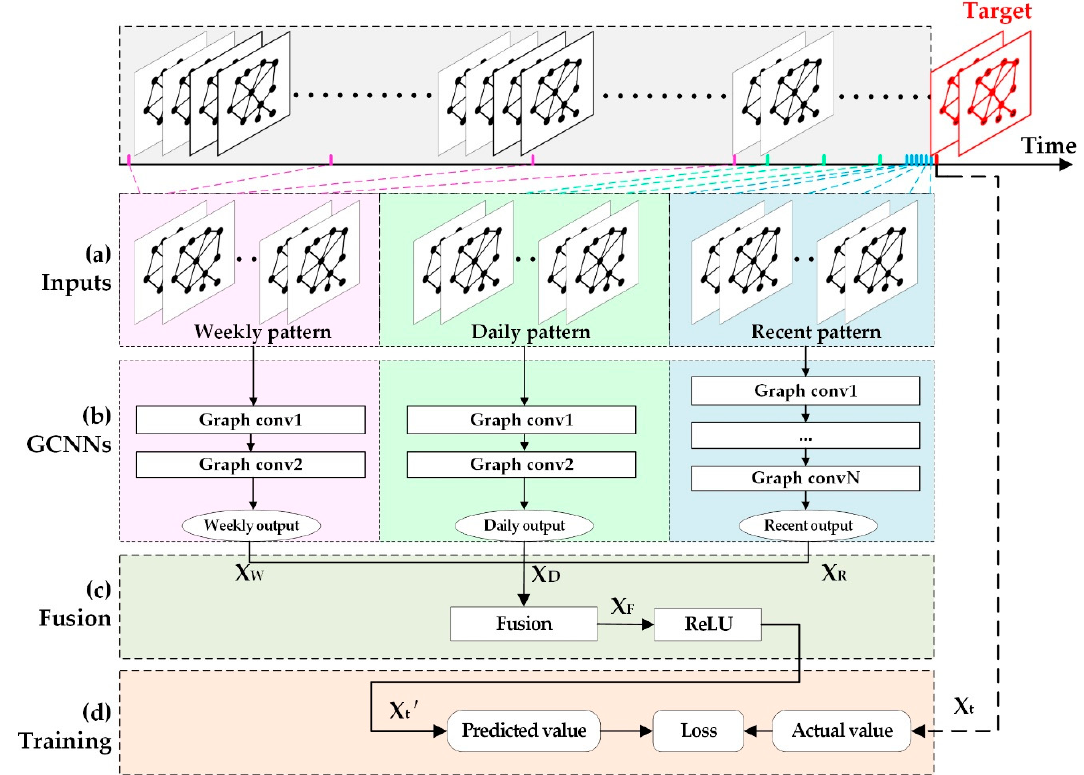
Figure 5. Architecture of the STGCNNmetro model. Conv: Convolution; X t and X t (cid:48) represent actual and predicted values in the t th time interval, respectively; X R , X D , and X W represent the outputs of